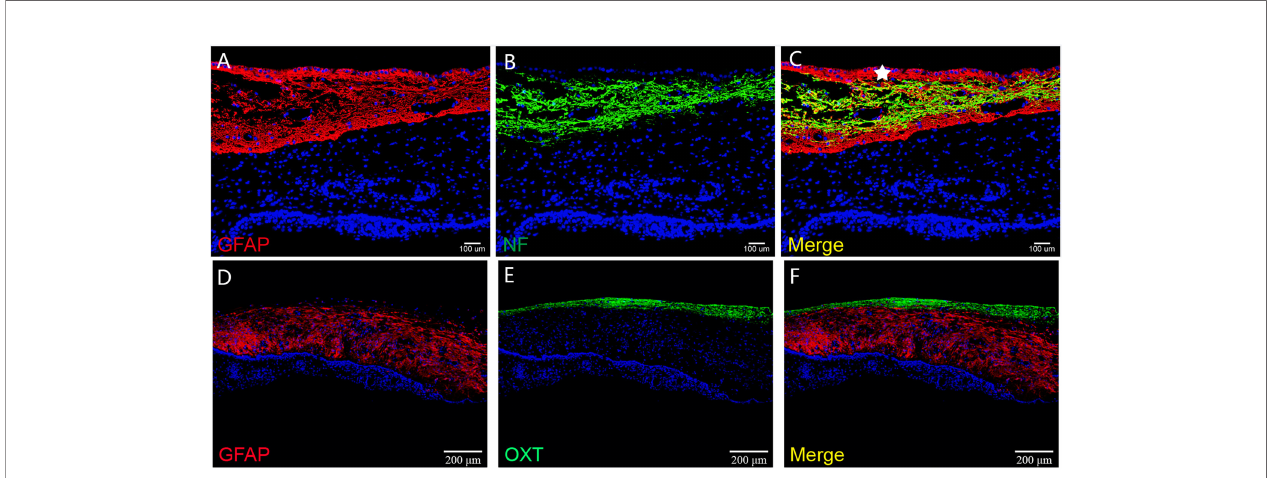
FIGURE 6 | The histological architecture between the tumor and the third ventricular fl oor. In (A – F) , immuno fl uorescent staining shows a layer of gliosis (GFAP positive) with various thickness between the tumor and the neural tissue of the third ventricle fl oor. The neural tissue of the third ventricle fl oor/hypothalamus (NF and OXT positive) can be observed on the outer border of the gliosis. The ependymal cells of the third ventricle (white pentagram) could be found in some samples, which indicated the extraventricular topography of CP.